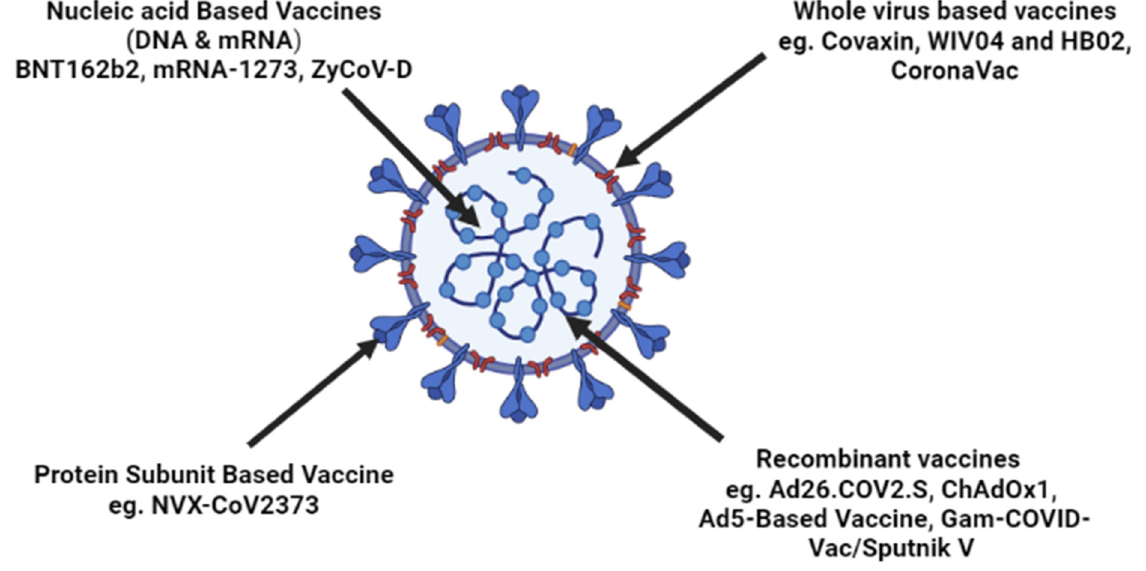
Figure 1. Strategies illustrating the type of vaccine implemented in controlling the SARS-CoV-2 spread.